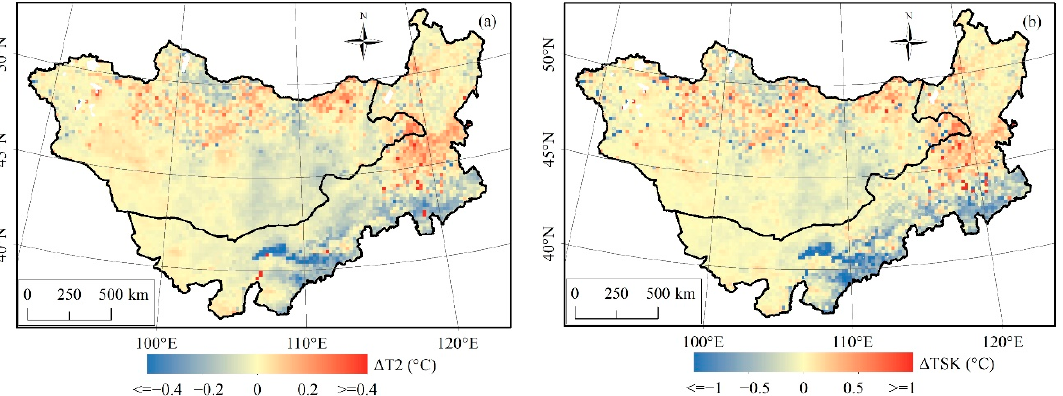
Figure 4. Model-simulated differences in T2 ( a ) and TSK ( b ) due to vegetation changes in the growing season between scenarios of SL1990s and